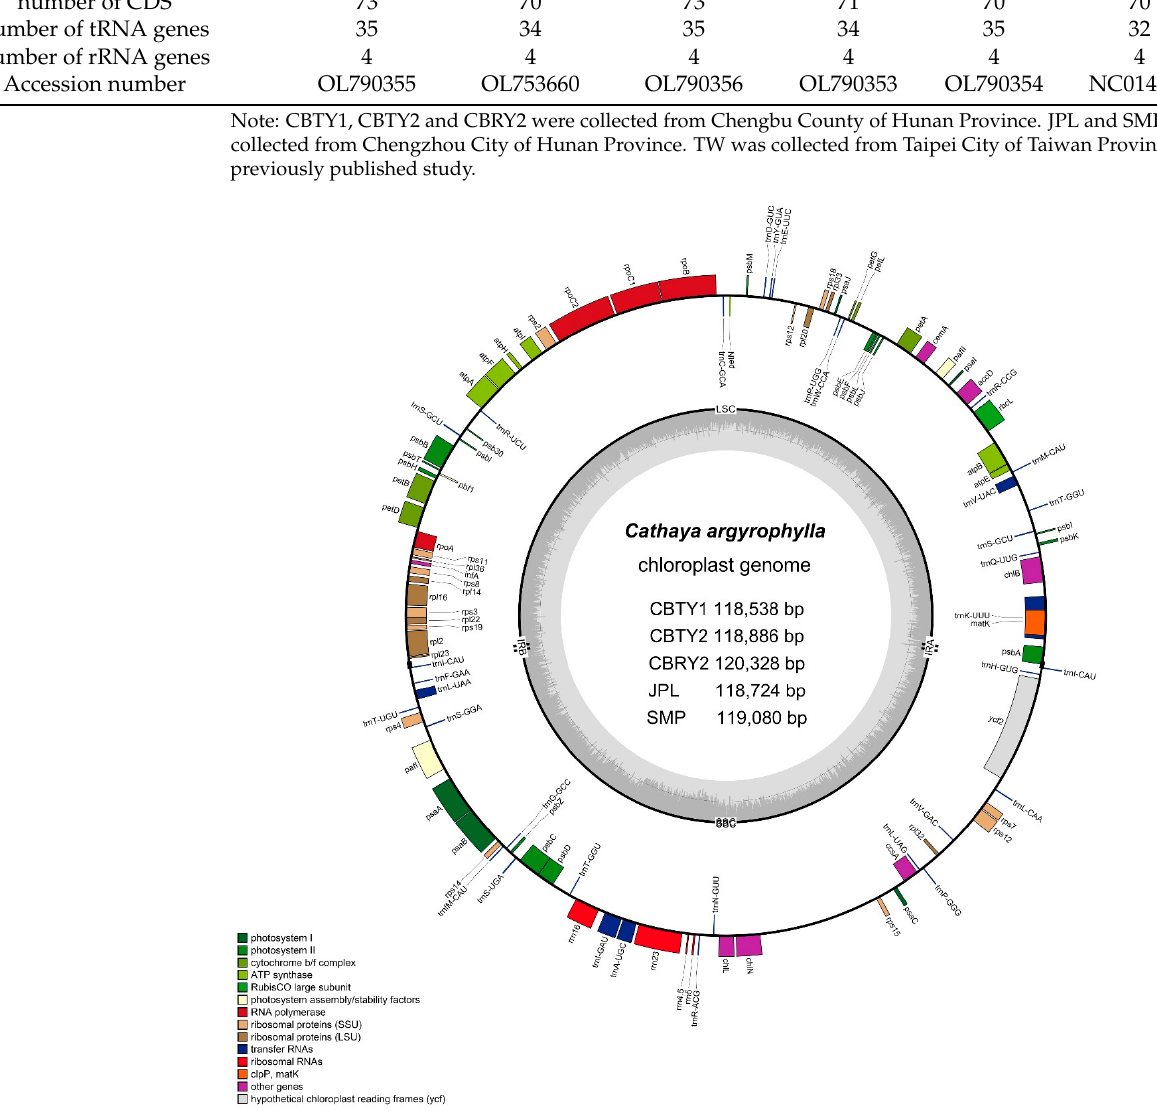
Figure 2. Gene map of the Cathaya argyrophylla chloroplast genome. The genes located within the circle were transcribed clockwise, while those outside were transcribed counterclockwise. The colors correspond to genes with different functions: the darker gray in the inner circle corresponds to DNA G + C content, while the lighter gray corresponds to A + T content. CBTY1, CBTY2 and CBRY2 samples were collected from Chengbu County of Hunan Province. JPL and SMP samples were collected from Chengzhou City of Hunan Province. Table 1. Chloroplast genome features of Cathaya argyrophylla populations from six locations in China.